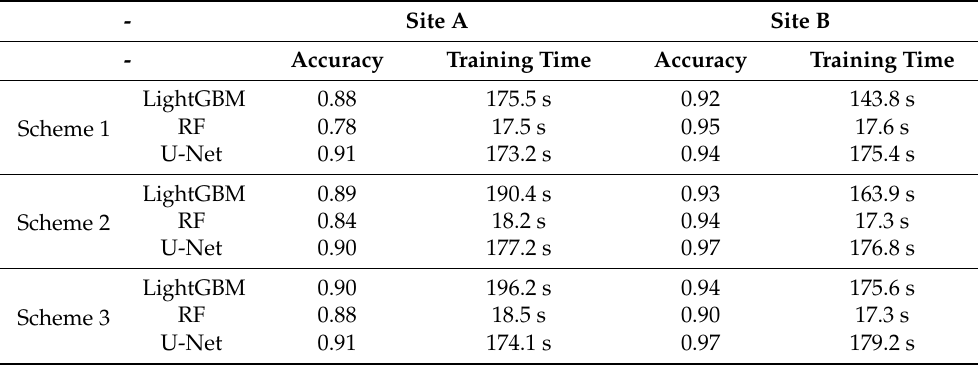
Table 6. Time requirement for training to detect burned